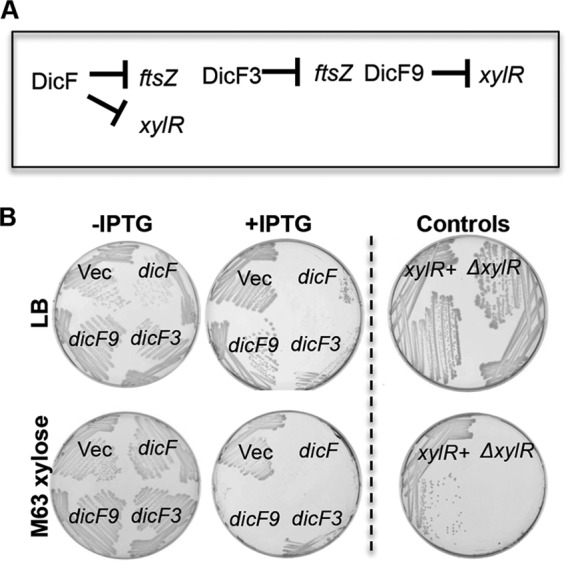
Physiological consequences of DicF-xylR mRNA interactions. (A) Schematic depicting regulatory interactions between DicF and xylR. The flattened arrowheads indicate translational repression of xylR and ftsZ by the indicated DicF RNAs. (B) ΔdicF lacIq strains harboring the Plac-vector or Plac-dicF, Plac-dicF3, or Plac-dicF9 were streaked on LB agar plates or M63 xylose plates with and without 0.5 mM IPTG. LB plates were incubated at 37°C for 12 h and M63 xylose plates for 22 h.